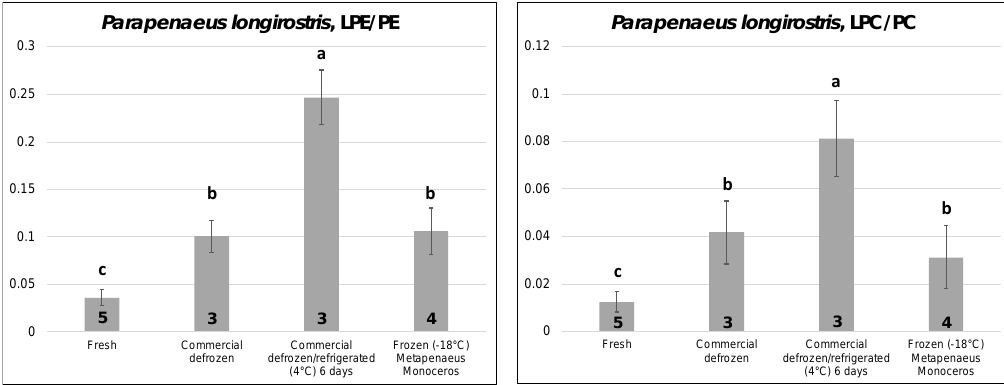
Figure 5. Comparison between LPE/PE and LPC/PC ratios of ESI(+)-FTMS responses obtained from